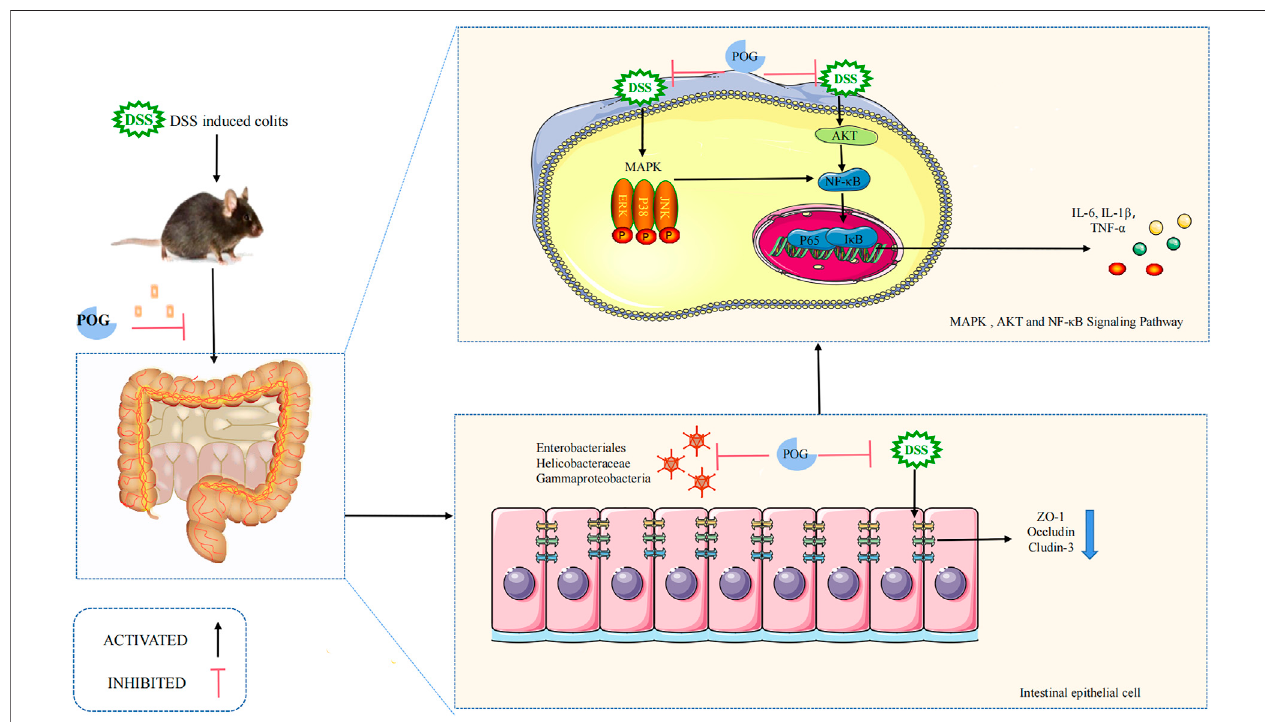
FIGURE10| MechanismofPOGininhibitingin fl ammationwhilemaintainingepithelialbarrierintegritywithinDSS-mediatedUC.DSSsuccessfullyinducedmiceUC model. Colonic tissue damage was obvious as in fl ammatory factor levels elevated. POG can reduce DSS-induced UC and inhibit in fl ammatory factor production while alleviating colonic edema. POG modulates gut fl ora to maintain intestinal homeostasis while protecting the intestinal immune barrier from impaired avoidance but also inhibits AKT, MAPK, and NF- κ B pathway activation, as well as in fl ammatory mediator expression (IL-1 β , TNF- α , and IL-6).